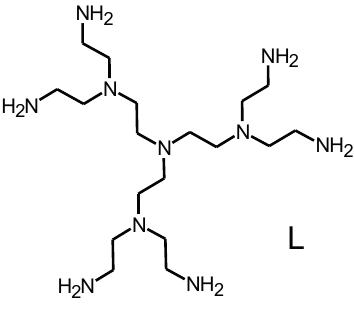
Figure 1. The G-2 poly(ethylene imine) dendrimer